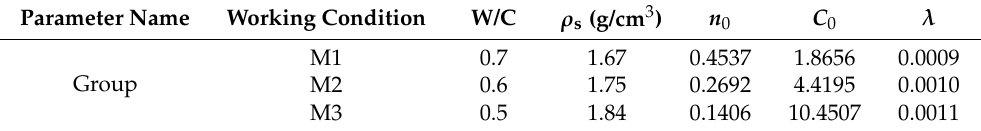
Table 2. Calculation parameters of the power-law slurry.